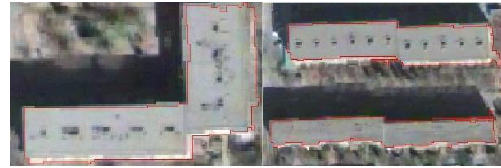
Fig. 6. Outlines of extracted buildings (the red ones).